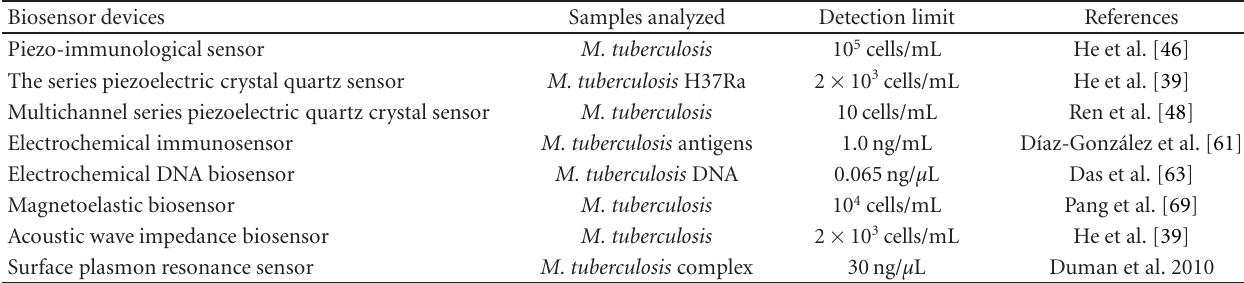
Table 2: Di ff erent kinds of biosensors for M. tuberculosis